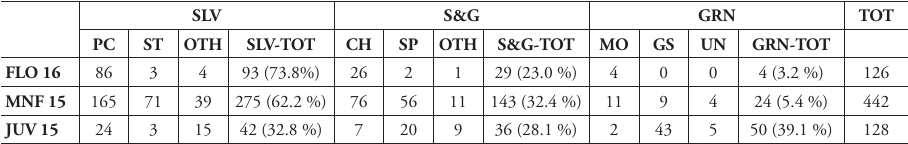
Table 1. Assignment of E. dens-canis individuals to leaf pattern categories. Major types: SLV (silvery), S&G (silvery-and-green), GRN (vivid green). Key to SLV subtypes: SLV-PC, pictorial (silvery ground with red-brown patterns); SLV-ST, silvery striped; SLV-OTH, other infrequent silvery forms. Key to S&G subtypes: S&G-CH, silvery-and-green chess-like; S&G-SP, silvery-and-green spotted; S&G-OTH, oth- er, infrequent silvery-and-green subtypes. Key to GRN subtypes: GRN-MO vivid green mottled (green ground with red-brown patterns; mature plants only); GRN-GS, vivid green with grey spots (juveniles only); GRN-UN, uniform vivid green (juveniles only). MNF and JUV were investigated in 2015, FLO plants in 2016. SLV S&G